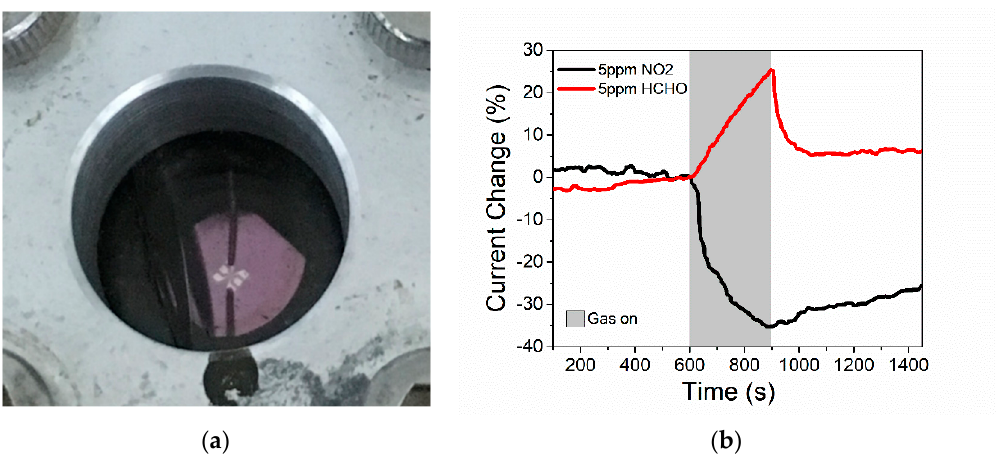
Figure 7. Gas sensing application of infiltrated devices. ( a ) First generation device in a gas sensing chamber. ( b ) Data showing the change of current (%) as a function of time as the device is exposed to 5 ppm of formaldehyde and 5 ppm of NO 2